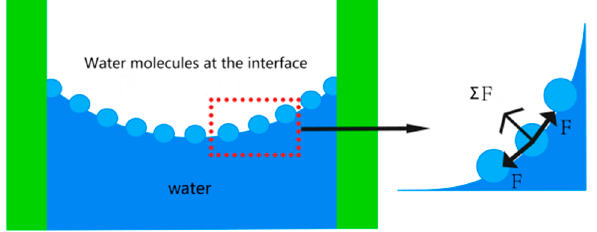
Figure 4. Mechanism of surface tension.